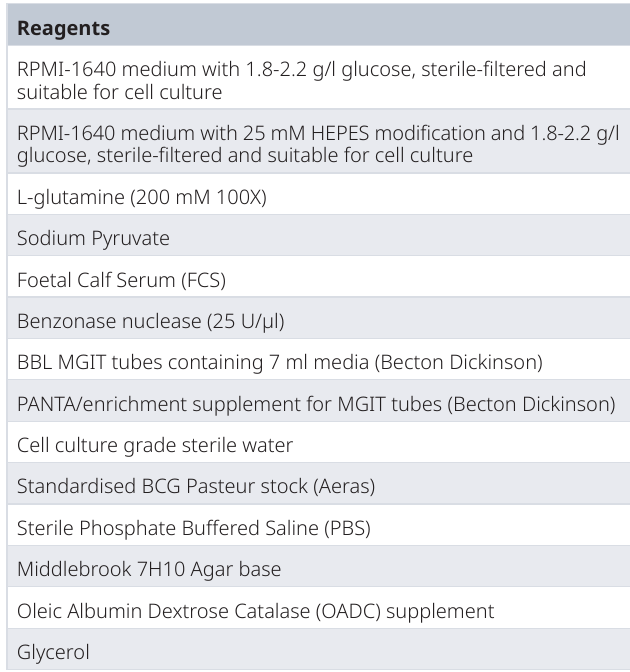
Table 2. Reagents required for the direct PBMC NHP